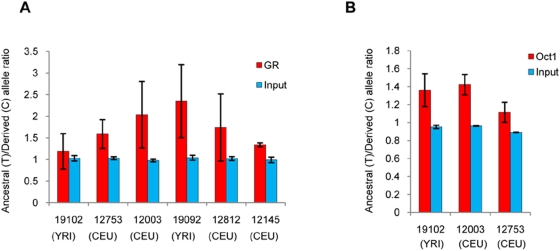
SNP rs9493857 affects GR and Oct1 DNA occupancy following dexamethasone (10−6 M) treatment in LCLs.ChIP experiments were performed in HapMap LCLs heterozygous for rs9493857. For each cell line (reported on the horizontal axis), the plot shows the PCR product ratio between the Ancestral and the Derived allele at rs9493857 in the samples immunoprecipitated in the presence of the (A) anti-GR antibody or (B) anti-Oct1 antibody and in the corresponding input samples.